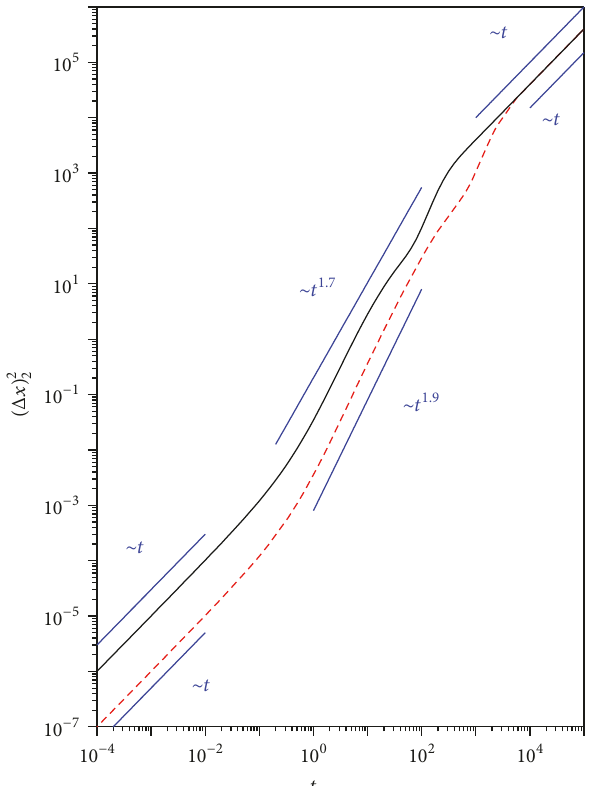
t∼t ∼t Figure4:Thisfigureillustratesthebehaviorofthemeansquaredisplacementforspecies 2 versus 𝑡 for 𝛼 = 1.0 .Theblacksolidlinecorresponds to the case 𝑘 = 10 −2 and the red dashed line is the case 𝑘 = 10 −3 . We consider, for simplicity, K 1 = K 2 = 1 , 𝜅 = 1 , and 𝜏 = 1 . We also use straight lines (blue) to evidence the different behavior of the mean square displacement. Figure 5: Behavior of the mean square displacement for species 1 versus 𝑡 , when different choices for the boundary conditions are performed. In (a) the black dashed-dotted line corresponds to the case 𝜅 = 1 with 𝜏 = 10 4 and the blue solid line considers 𝜅 = 0 . For these cases, for simplicity, we used K 1 = 1 and 𝑘 = 1 . In (b) the black dashed-dotted line is the case 𝜅 = 1 with 𝜏 = 10 6 and the blue solid line considers 𝜅 = 0 . We also use straight lines to evidence the different behavior of the mean square